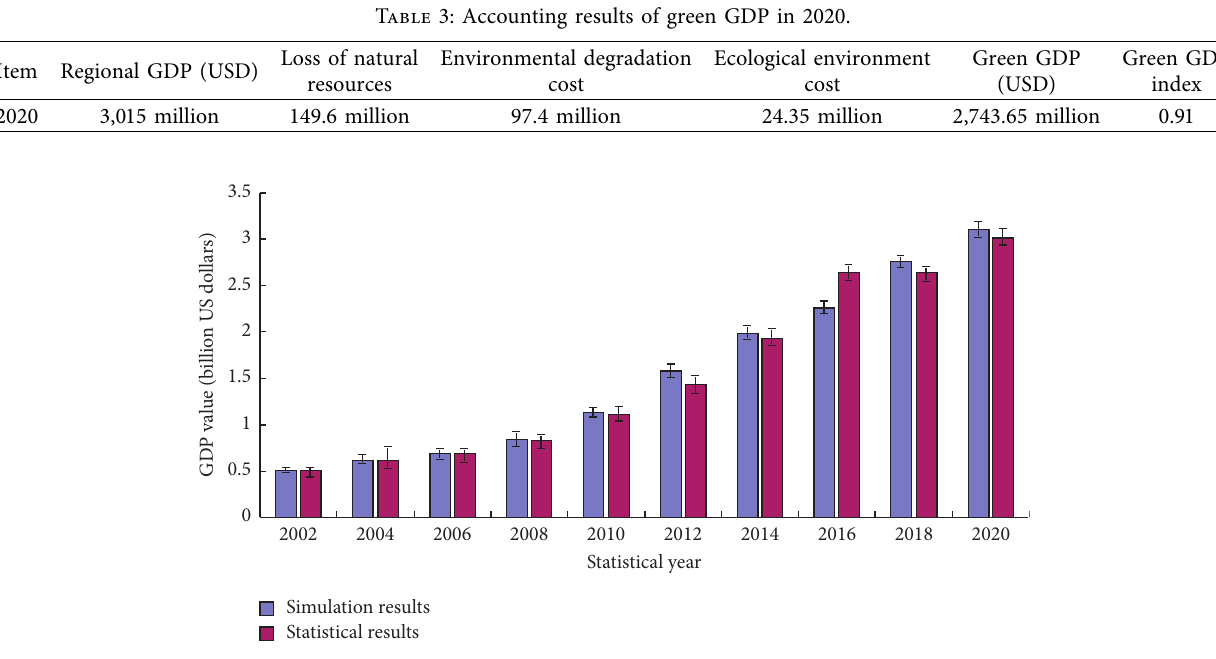
Figure 3: Comparison results of simulated and statistical values of GDP